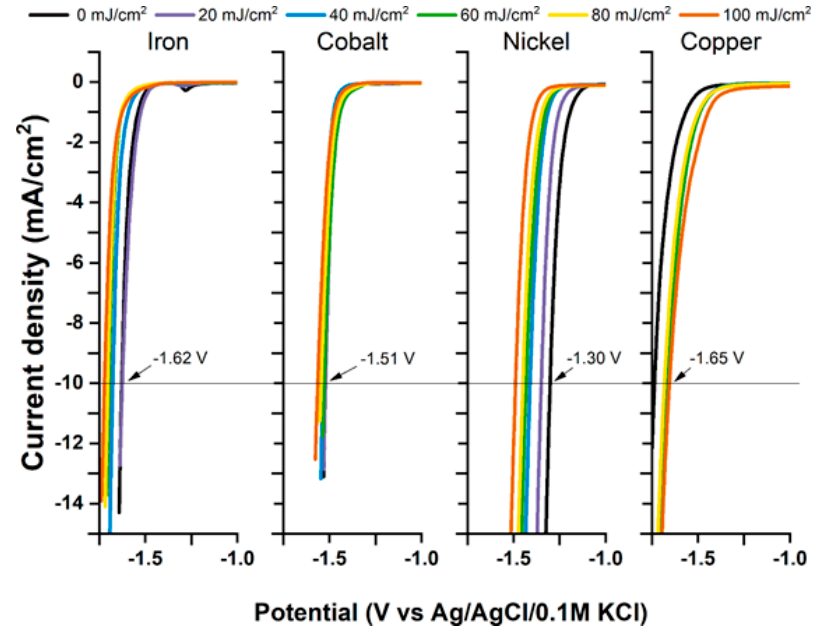
Figure 12. Potentials of hydrogen evolution reaction for metal-modified and laser-treated samples. The HER potential for unmodified nanotubes is − 1.72 V. Reprinted with permission from